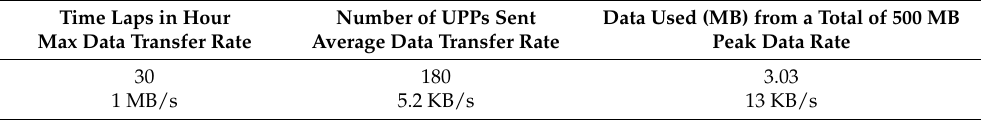
Table 3. Data Usage vs. time in hours. :